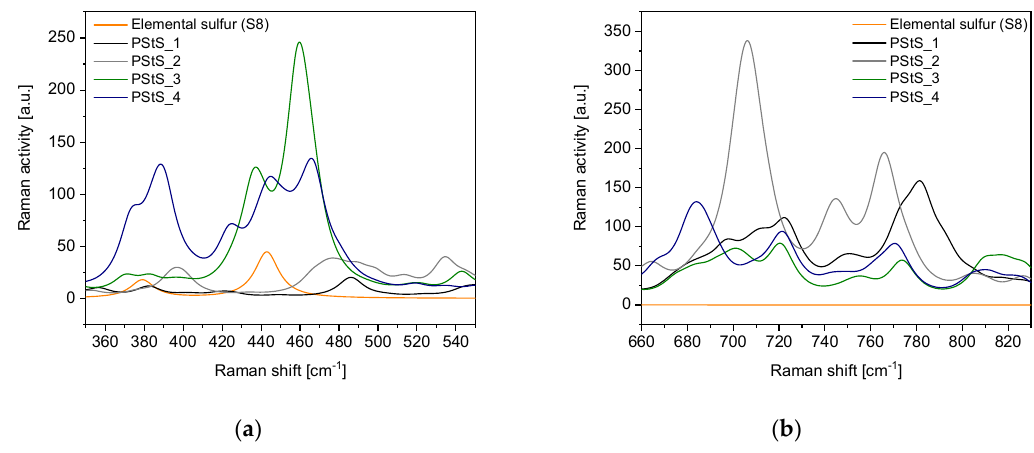
Figure 6. Calculated Raman spectra of poly (styrene oligosulfides) with various length of sulfur bridges: ( a ) in the range characteristic for the polysulfide (-S x -) bonds, ( b ) in the range characteristic for the C–S bonds. The spectrum of elemental sulfur was added for comparison.